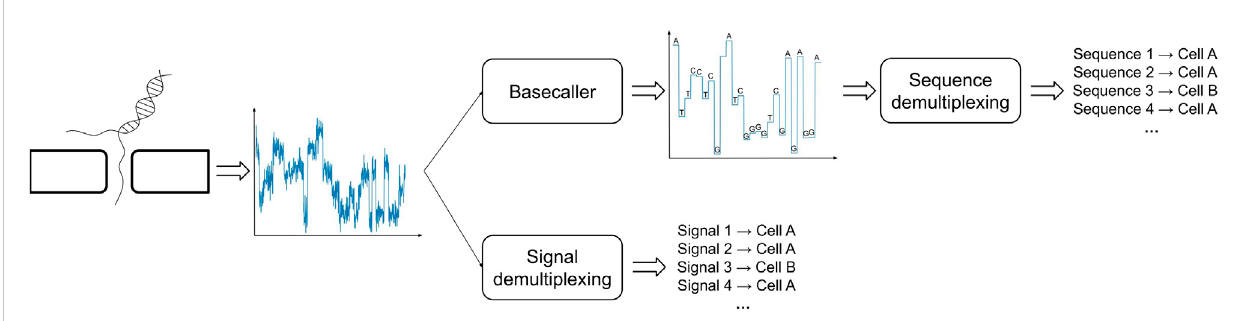
FIGURE 2 Demultiplexing of BC signals in ONT sequencing can be carried out using basecalled (top) or raw (bottom)